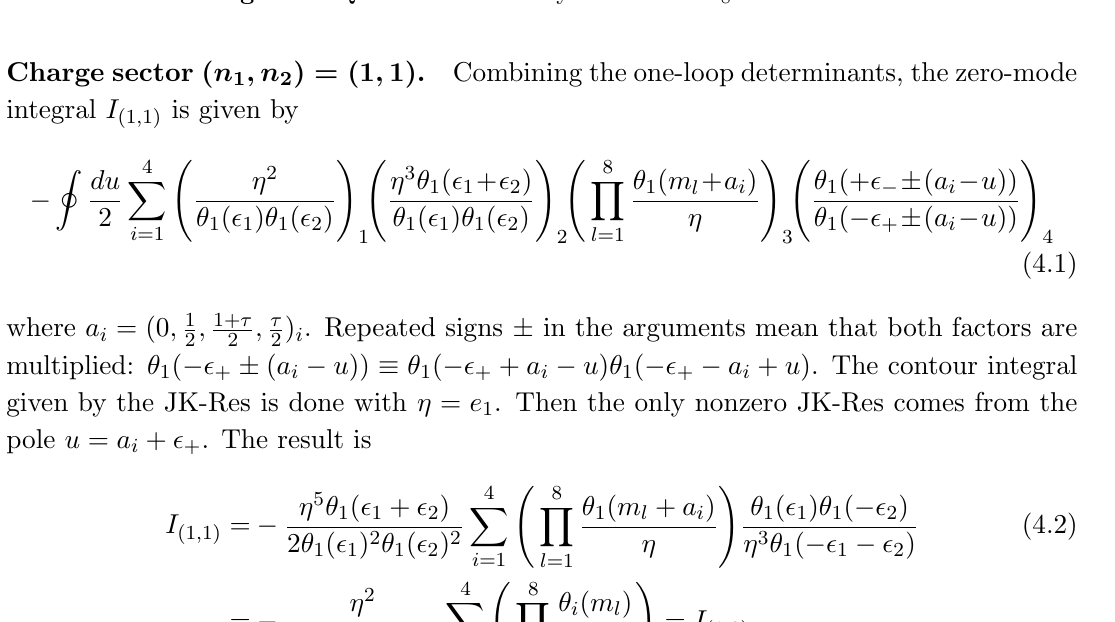
Figure 7 . Quiver for the theory of N small E